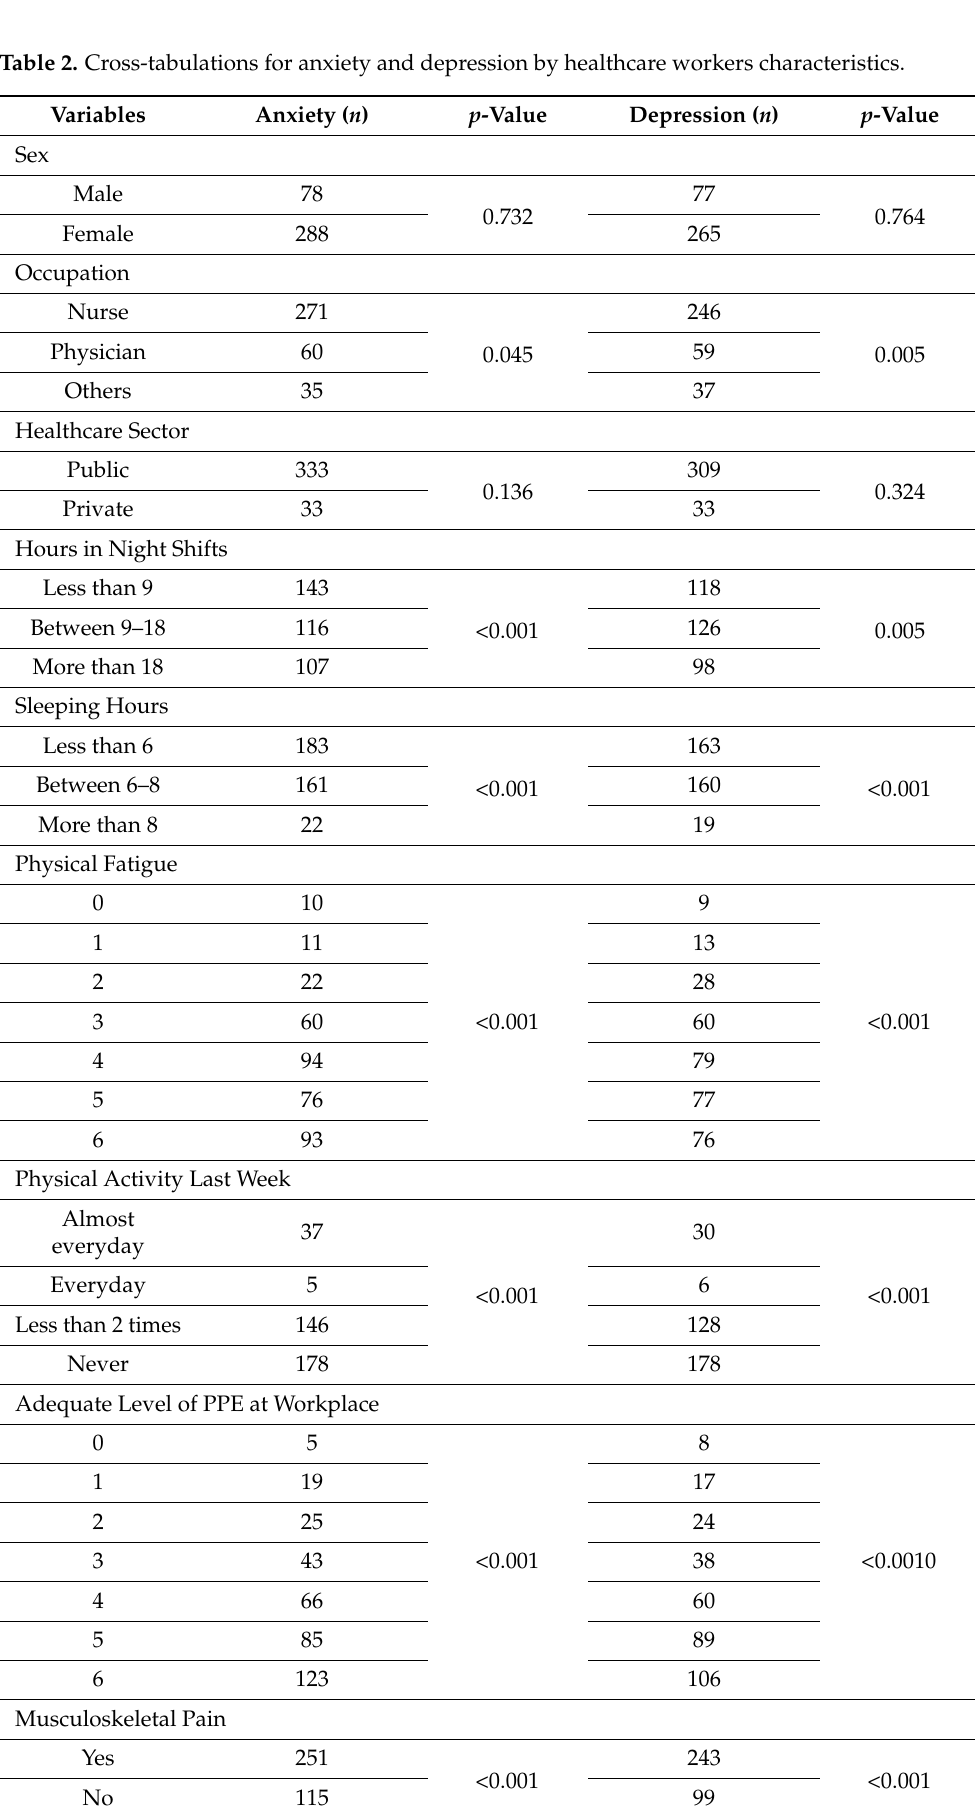
Table 2. Cross-tabulations for anxiety and depression by healthcare workers